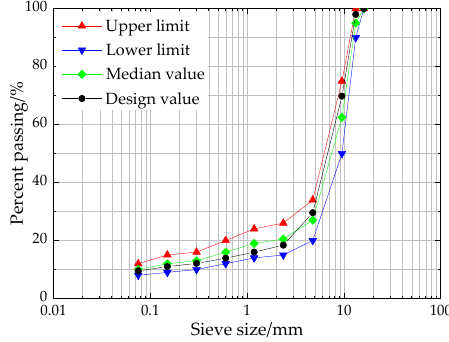
Figure 2. Gradation of stone matrix asphalt (SMA)-13 used in this study.